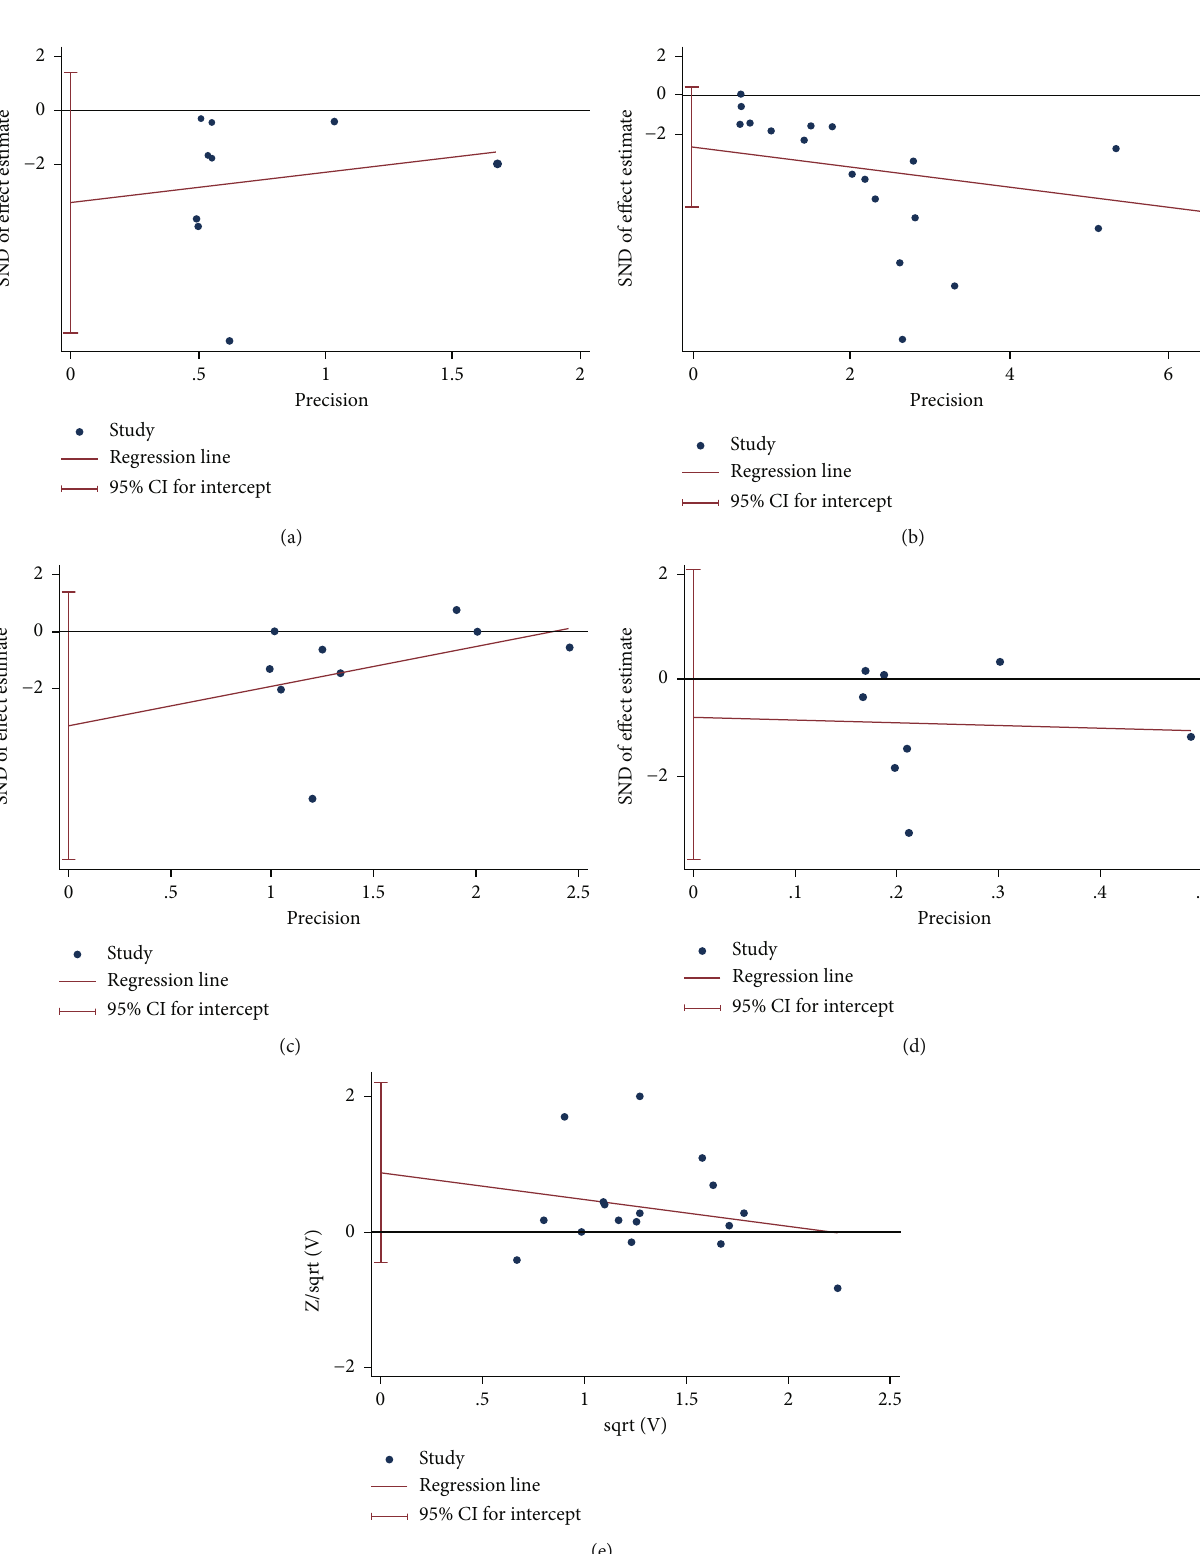
Figure 14: Publication bias: (a) WOMAC pain; (b) VAS; (c) WOMAC sti ff ness; (d) WOMAC physical function; (e) adverse